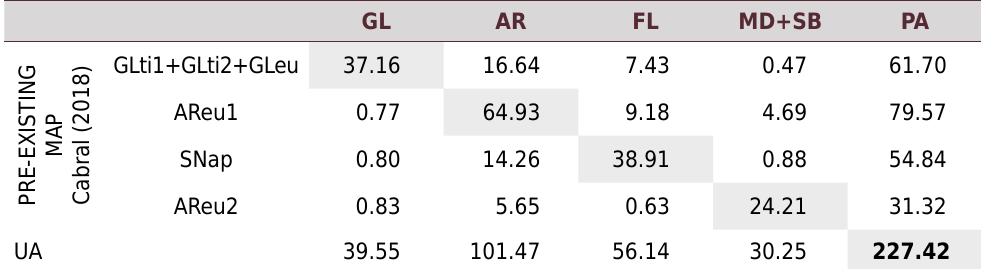
Table 7. Confusion matrix of the comparison between mapping 2 and the traditional mapping GL AR FL MD+SB PA GLti1+GLti2+GLeu 37.16 16.64 7.43 0.47 61.70 G 2018 ) N T I AReu1 0.77 64.93 9.18 4.69 79.57 P S ( A X I M a l E SNap 0.80 14.26 38.91 0.88 54.84 b r E - a R C P AReu2 0.83 5.65 0.63 24.21 31.32 UA 39.55 101.47 56.14 30.25 227.42 GLeu: Eutric Gleysol ( Gleissolo Háplico ); GLti: Thionic Gleysol ( Gleissolo Tiomórfico ); AReu: Eutric Arenosol ( Neossolo Quartzarênico ); SNap: Abruptic Solonetz ( Planossolo Nátrico ); GL: Soils with gleyc characteristics; AR: Soils with sand texture; FL: Soils with fluvic materials; MD: Mobile dunes; SB: Sand beach; UA: User’s accuracy; PA: Producer’s